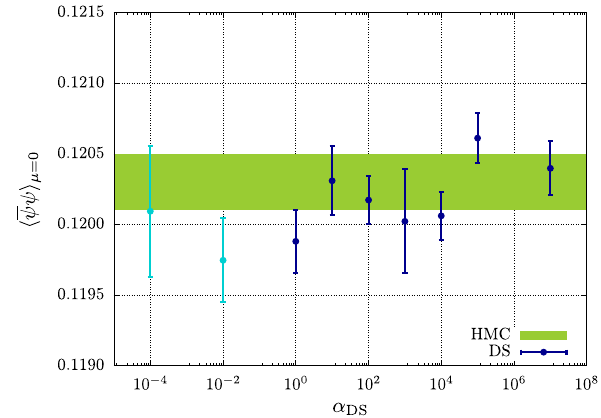
Fig. 13 The chiral condensate at zero chemical potential as a function of α DS . The green band represents the value obtained from a HMC simulation. The simulations were carried out in a volume of 6 3 × 6, four quark flavours of mass m = 0 . 025, and gauge coupling β = 5 . 6